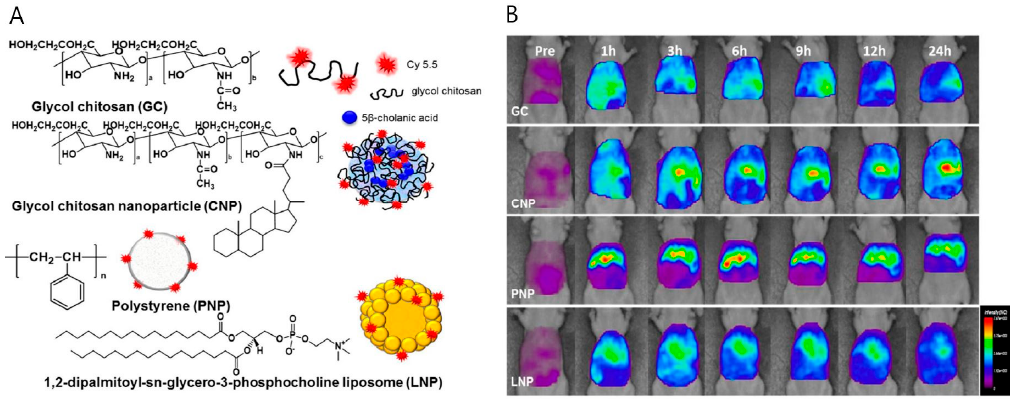
Figure 3. ( A ) Chemical structures of glycol chitosan (GC), glycol chitosan–5 β -cholanic acid nanoparticle (CNP), polystyrene nanoparticle (PNP) and 1,2-dipalmitoyl- sn -glycero-3-phosphocholine liposome (LNP); ( B ) in vivo NIRF images of liver tumor-bearing mouse model at 0, 1, 3, 6, 9, 12 and 24 h after systemic injection of Cy5.5-labeled nanoparticles (Adapted with permission from [42]. Copyright 2016 American Chemical Society).